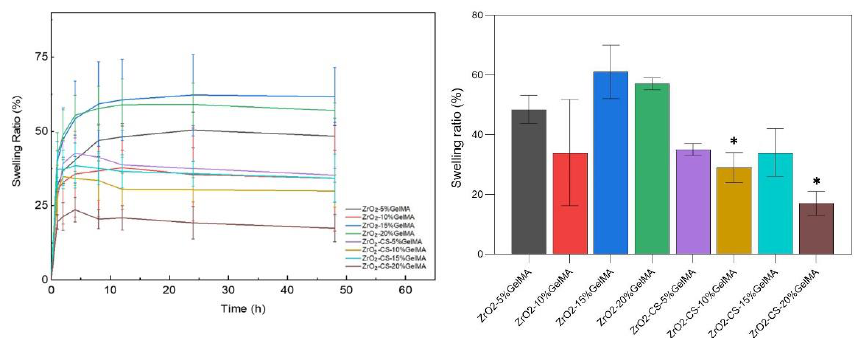
Figure 6. Swelling performance of zirconia-based composite scaffolds, * p < 0.05 .